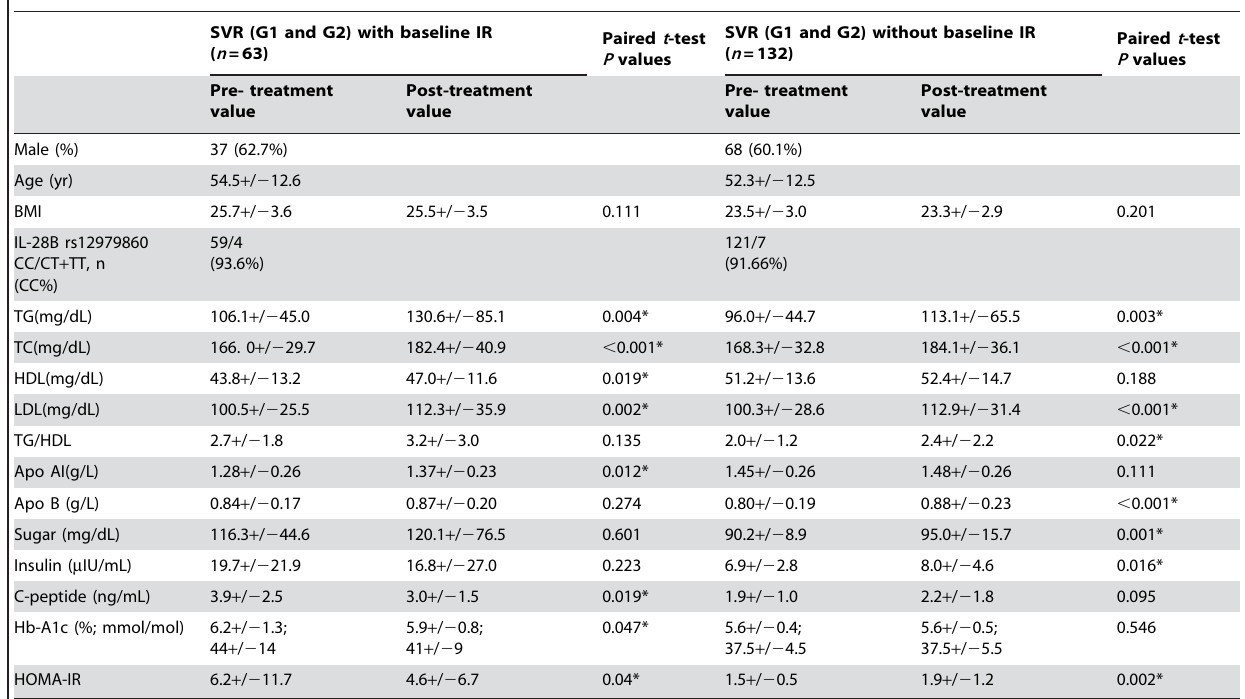
Table 4. Comparison of pre- and post-treatment variables in the CHC patients with SVR stratified by baseline IR.